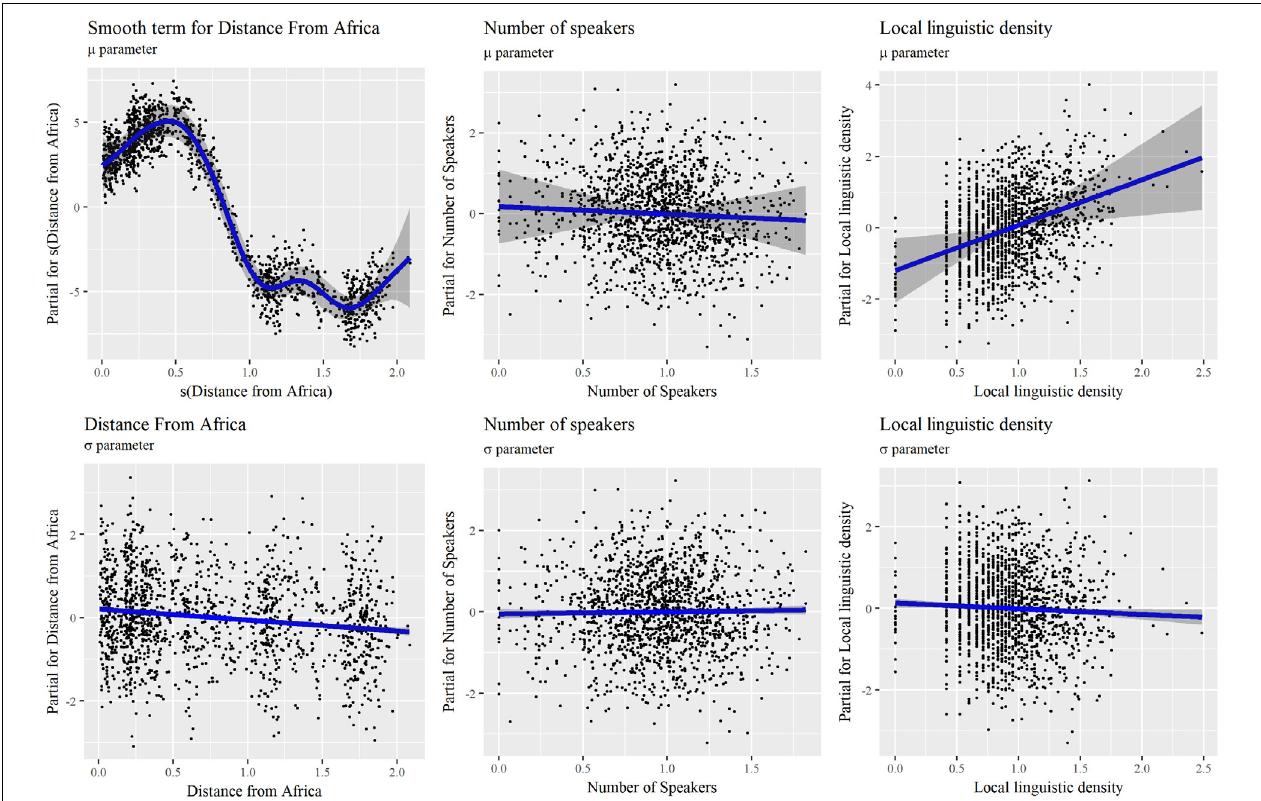
FIGURE 8 | Additive terms for Distance from Africa , Number of Speakers, and Local linguistic density for the µ and σ components of the (BCT, µ , σ , and ν ) model reported in Tables 5 , 6 . A P-splines smooth function is applied to Distance from Africa for µ .